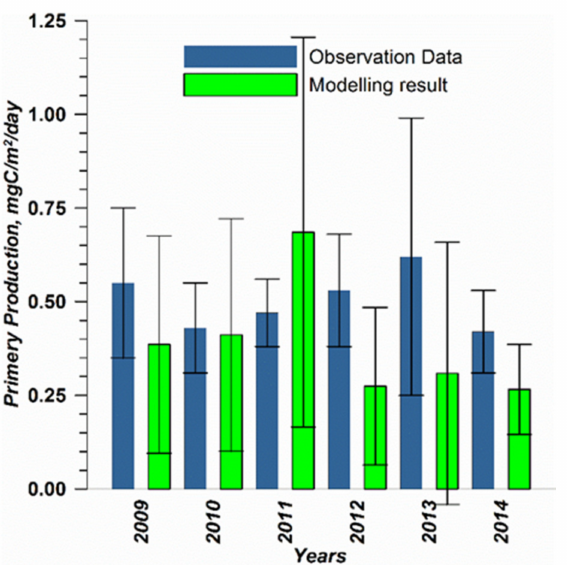
Figure 11. Statistical comparison of the primary production, simulated as the phytoplankton growth rate, including the nitrogen fixation, and measured by the bulk light–dark oxygen method at the end of July until the beginning of August in the Eastern Gulf of